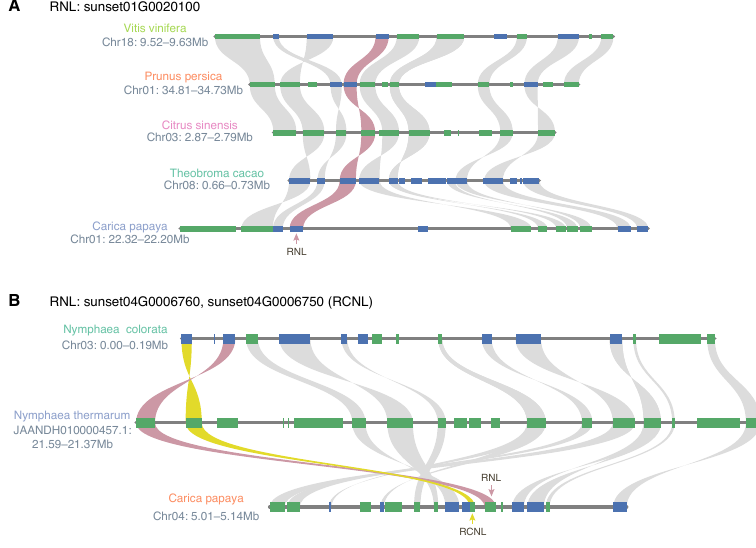
Figure 5. Inheritance-derived NLRs in papaya. ( A ) Conservation of a single RNL ( sunset01G0020100 ). ( B ) Conservation of RNL ( sunset04G0006760 ) and RCNL ( sunset04G0006750 ).